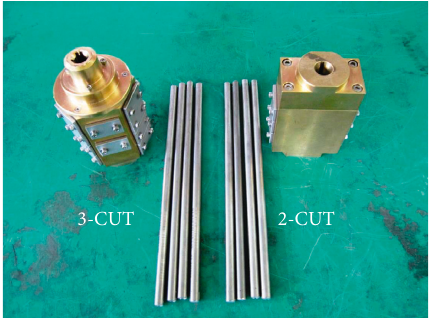
Figure 4: Blade types and simulated rod-cuts (2-CUT and 3-CUT modules).